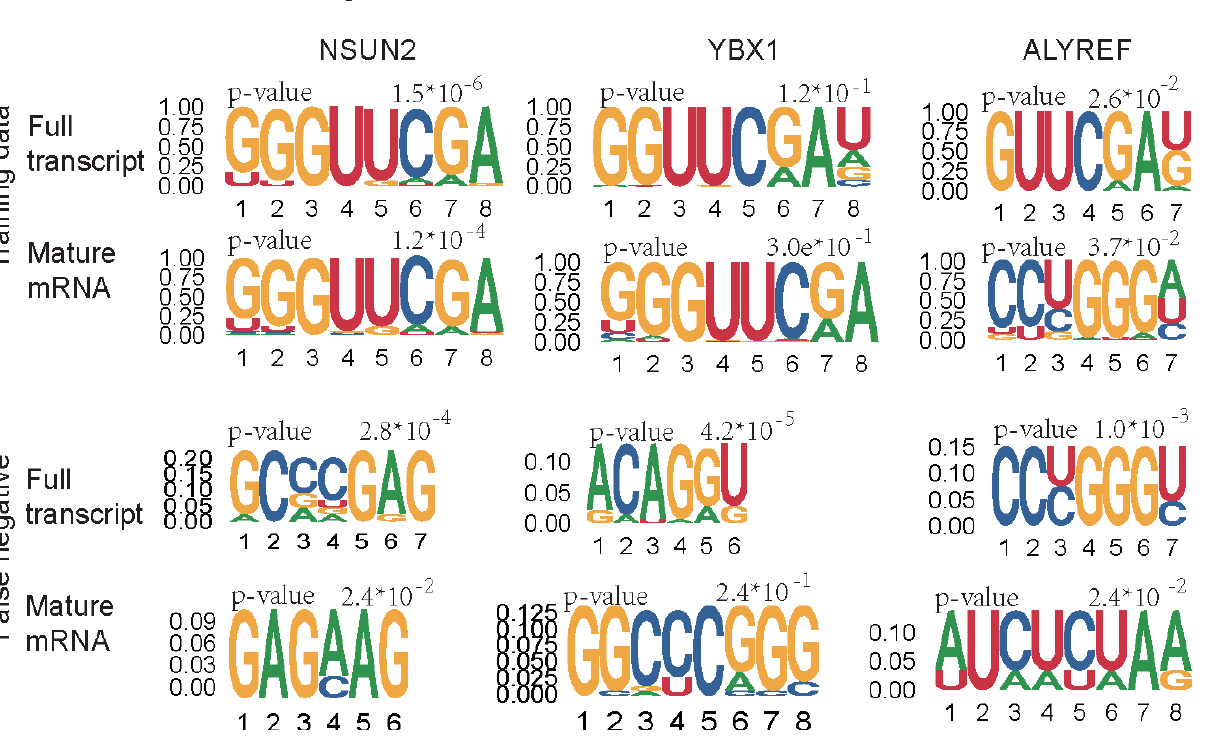
Figure 5. Motif discovery for the training data and false-negative sites of independent test